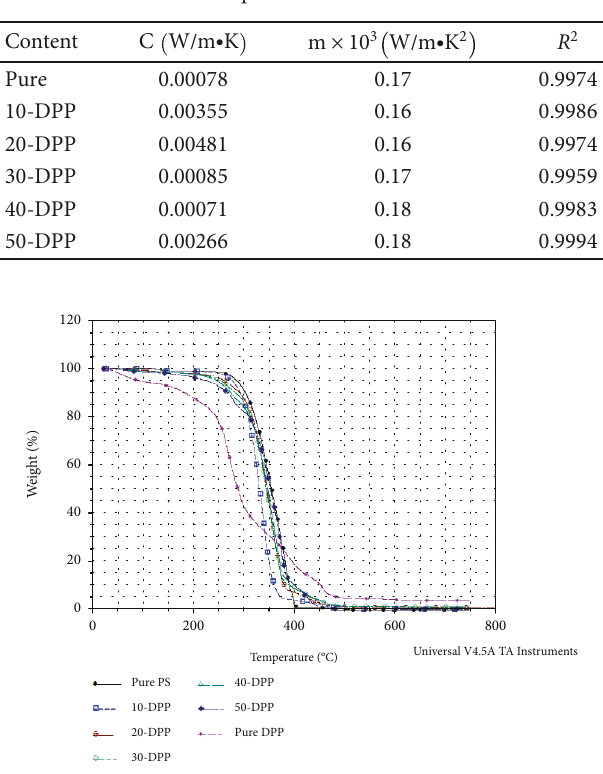
Figure 10: Thermograms of date pit – polystyrene composites with di ff erent fi ller contents.